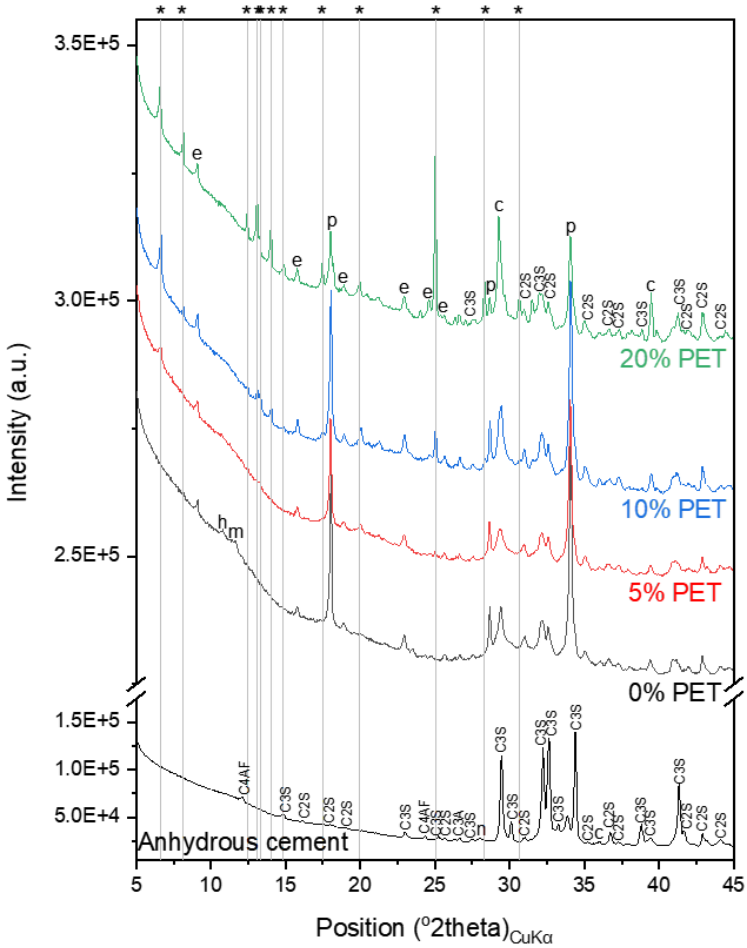
Figure 6. XRD patterns of cement paste samples incorporating PET powder. The following notations were used to denote: c: calcite; e: ettringite; h: hemicarboaluminate; m: monocarboaluminate; p: portlandite. Asterisks denote new phase identified in PET-incorporating samples.